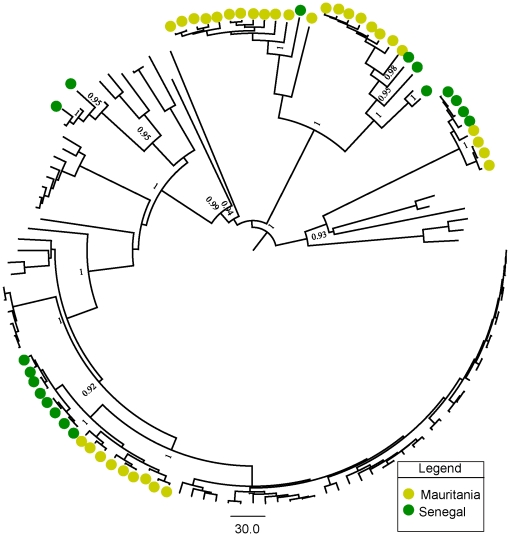
Maximum clade credibility (MCC) tree for the medium (M) segment.Relationship among 128 strains of RVFV isolated from different localities and countries. Samples from Mauritania and Senegal are shown by green and yellow dots respectively. The recurrent independent clustering of green and yellow dots suggests multiple introductions of RVFV into these countries throughout the 20th century. Posterior probability values greater than 90% are shown near tree nodes.